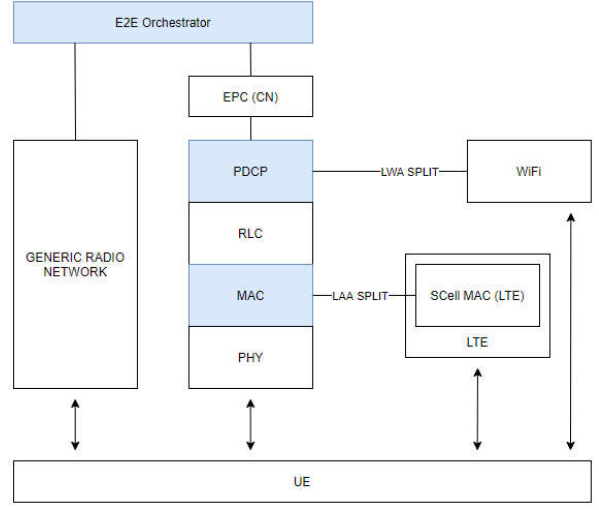
Figure 1. The architecture of LTE networks with locations (marked in color), in which a decision to split the data stream can be made to/from the user terminal (UE).